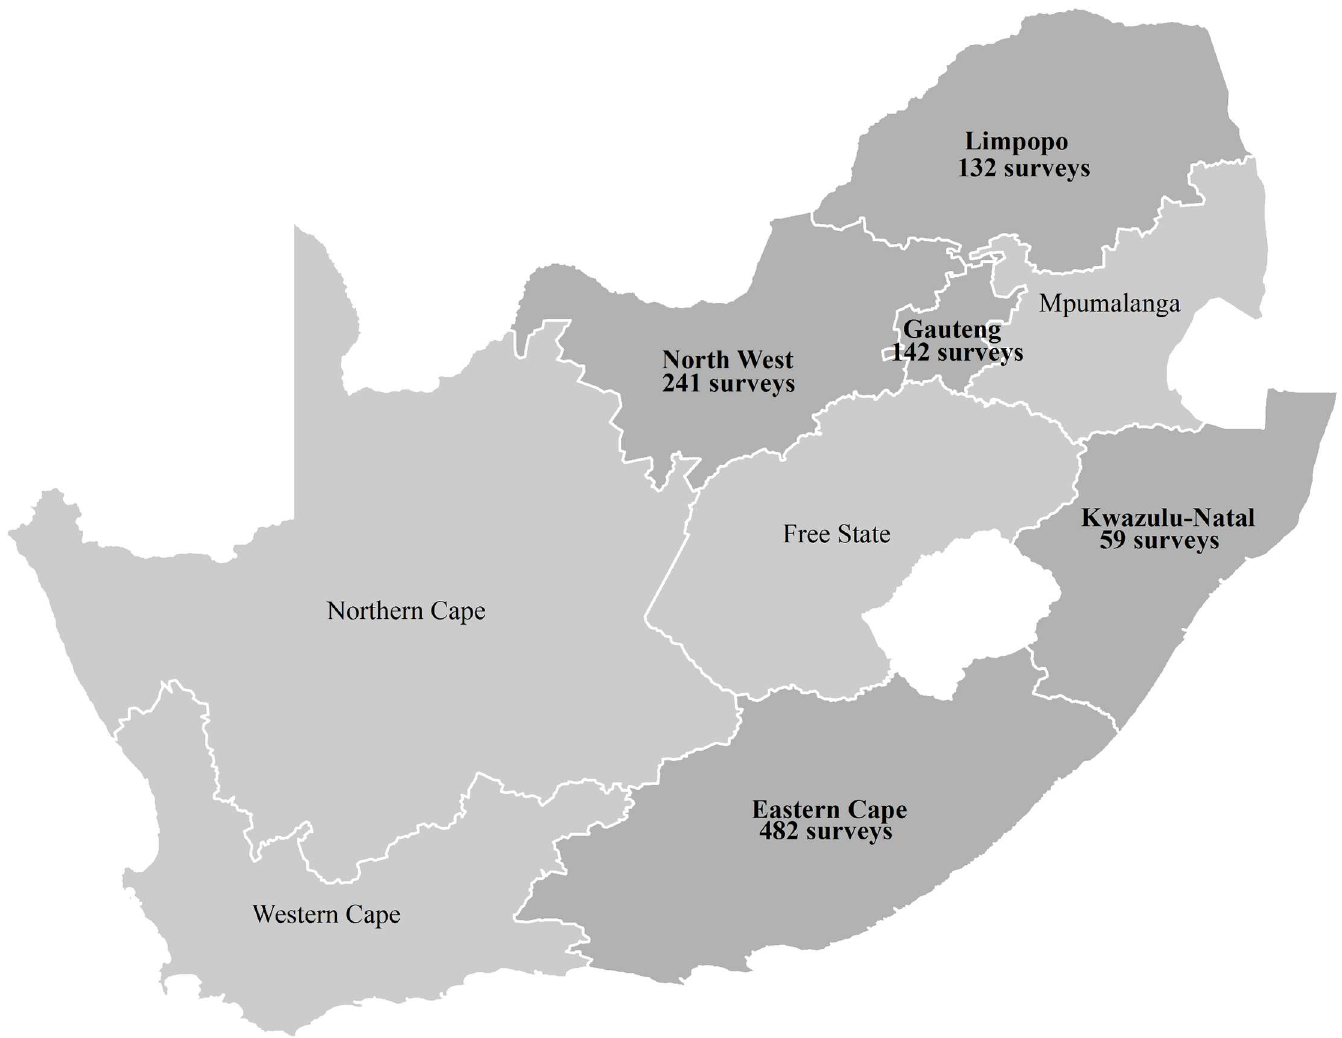
Fig 1. Number of surveyscompleted by province, South Africa (N = 1056) ΩΩ Missing: province (n = 108).